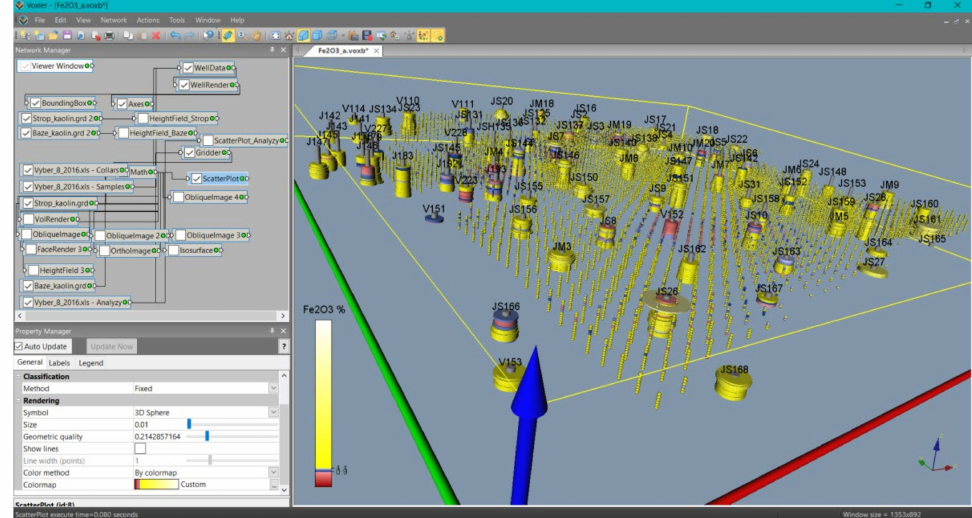
Figure 14. Three-dimensional visualization of the Fe 2 O 3 content—Plotting the 3D grid using ScatterPlot.